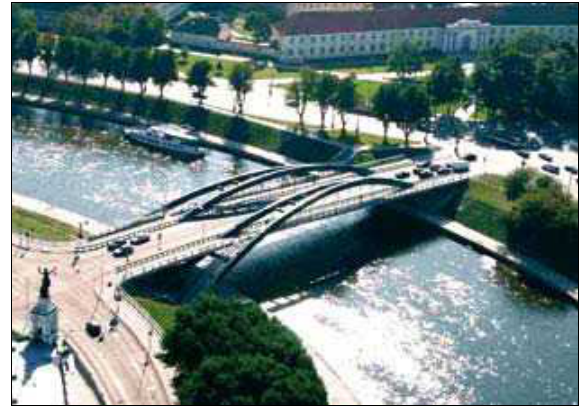
Fig. 7. king’s Mindaugas bridge in Vilnius Fig. 8. nowadays buildings are built only by the law of the